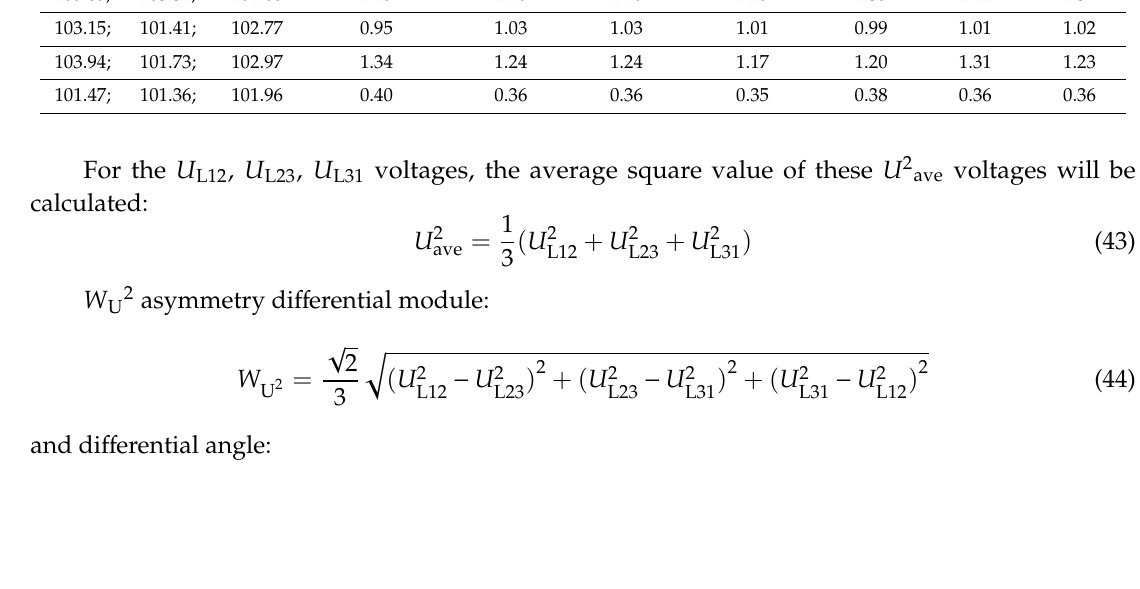
Table 1. The values of the asymmetry coe ffi cient determined by various methods. Voltage (%) Measurement